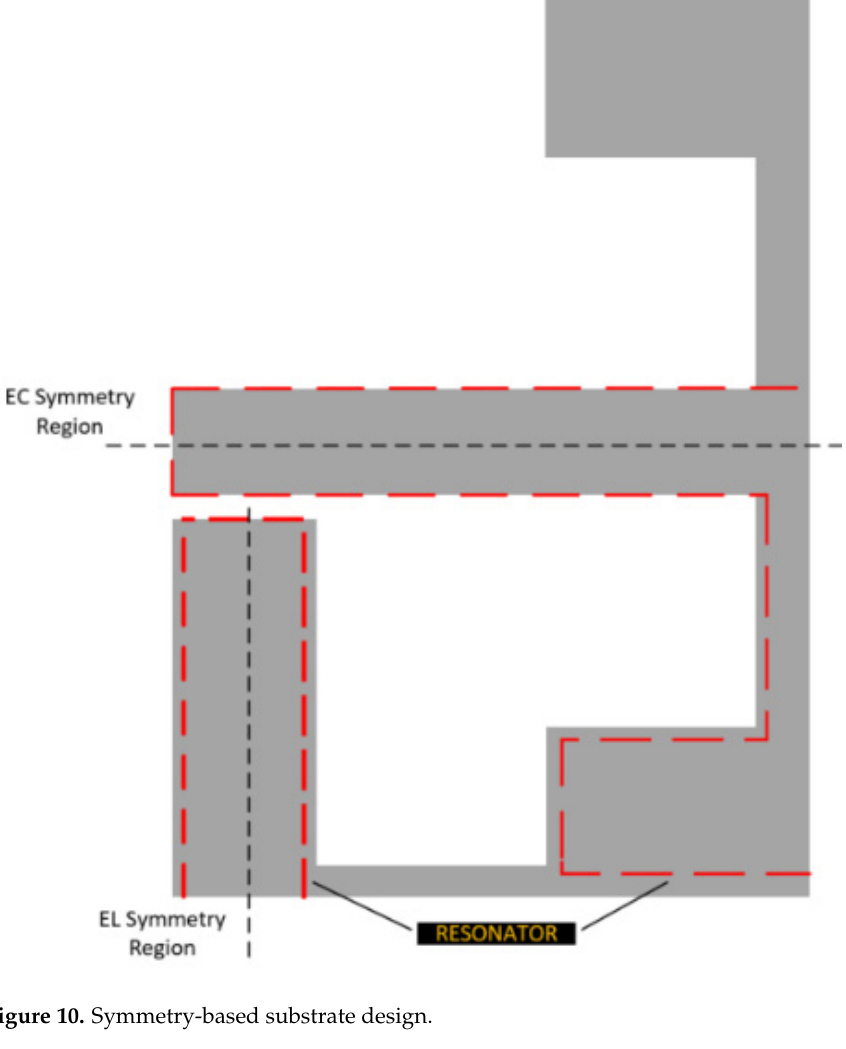
Figure 10. Symmetry-based substrate design.